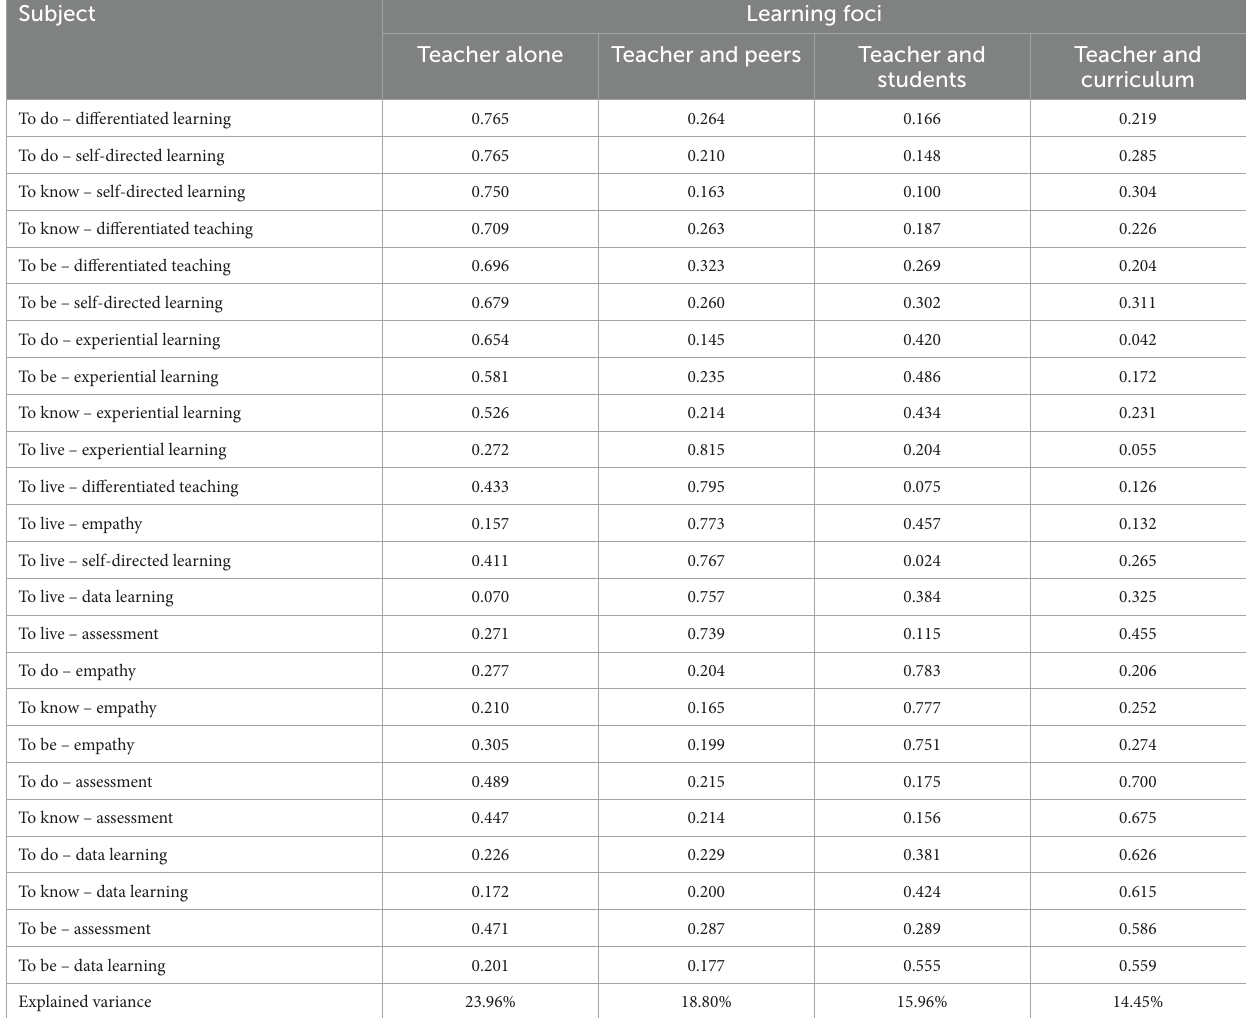
TABLE 3 Factor analysis and loadings of questionnaire on teachers’ learning methodologies and types of knowledge